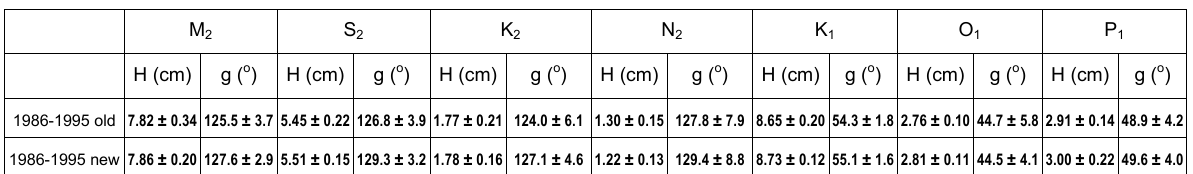
Table 2. Average amplitudes and phases, together with standard deviations calculated for 1986–1995 by using old VAX and new AutoCAD- based